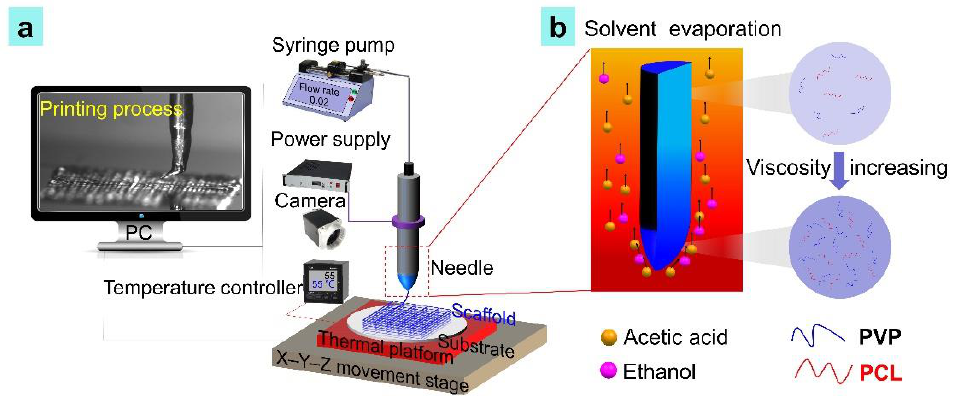
Figure 1. ( a ) Schematic diagram showing the TVEJ printing process; ( b ) local biopolymer concentration and tip viscosity increasing during printing.